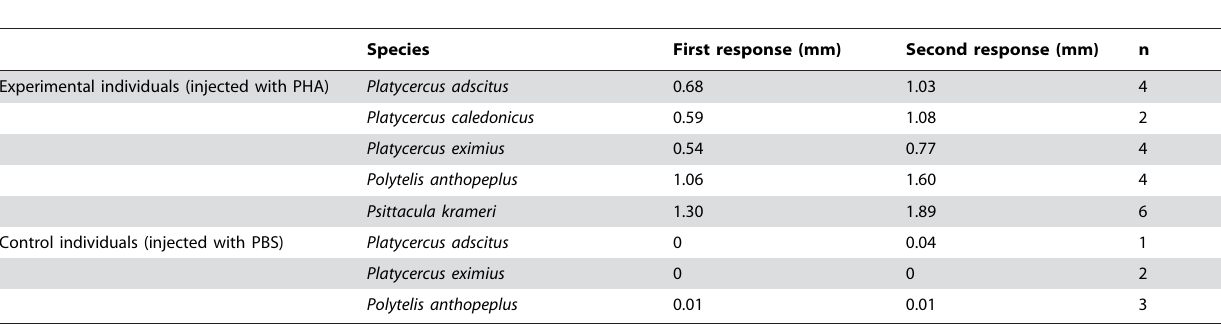
Table 2. Species and number of individuals used to quantify changes in lymphocyte subsets and plasma proteins associated with the primary and secondary responses to PHA